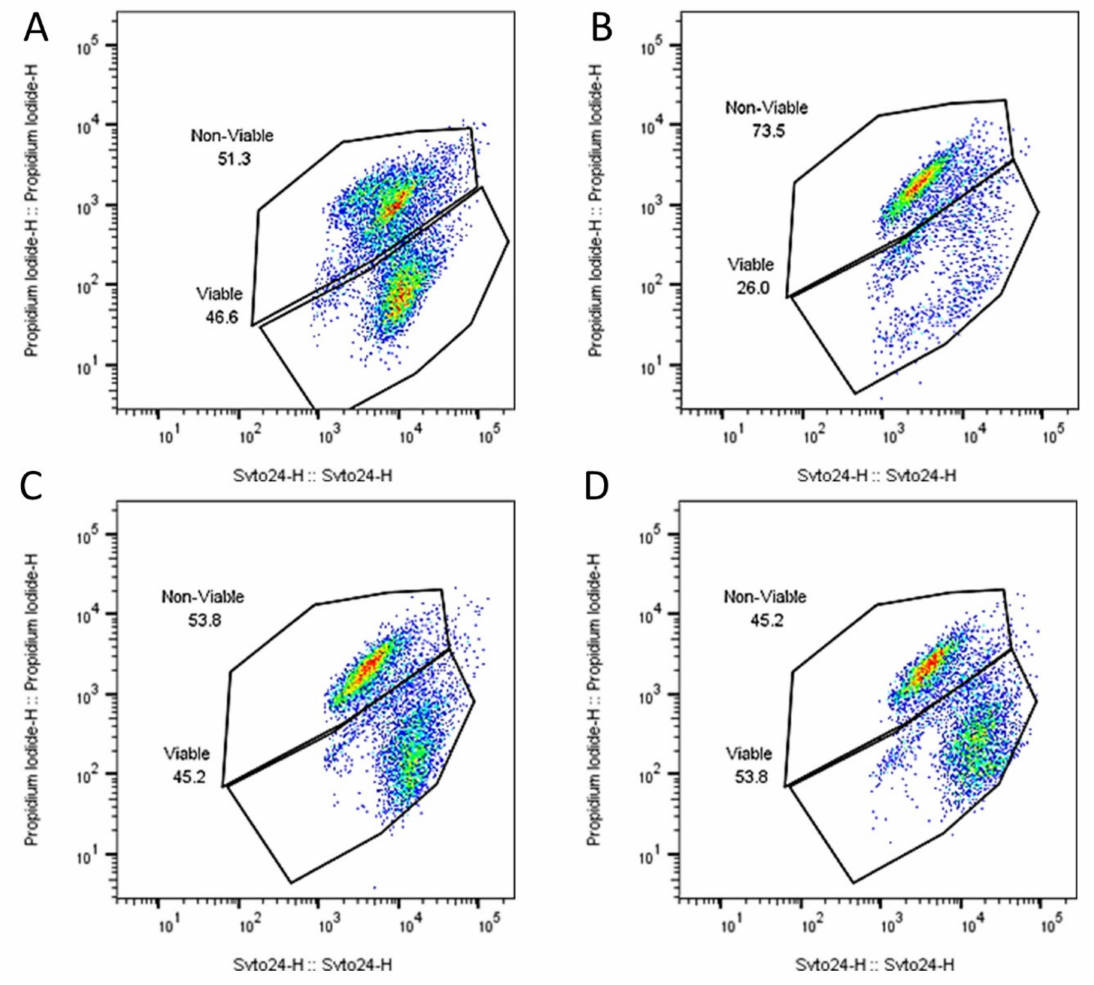
Figure 1. Representative flow cytometry dot plots of viable and non-viable probiotic cells in the SH-DS01 capsule ( A ) at the end of the gastric digestion stage ( B ), after 1.5 h of small intestinal digestion ( C ) and at the end of small intestinal digestion (3 h) ( D ). Bacterial cells were quantified with a double fluorescence staining of propidium iodide (non-viable cells) and SYTO24 (viable